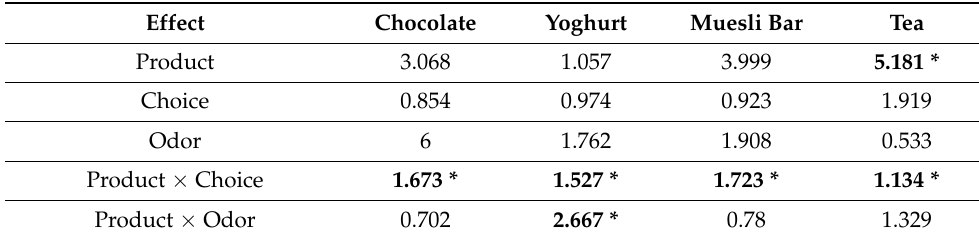
Table 2. Repeated measures ANOVA presenting the F-values of the three main effects and two of their interactions for the four product groups.